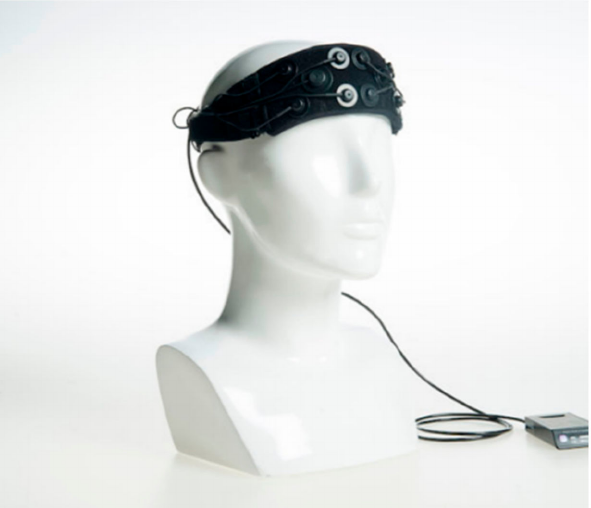
Figure 9. An eight-channel fNIRS device built by Artinis for imaging of the prefrontal cortex. (Reprinted from Artinis OctaMon, with permission from Artinis Medical Systems. Copyright 2021. Available online: https://www.artinis.com/octamon accessed on 12 September 2021).